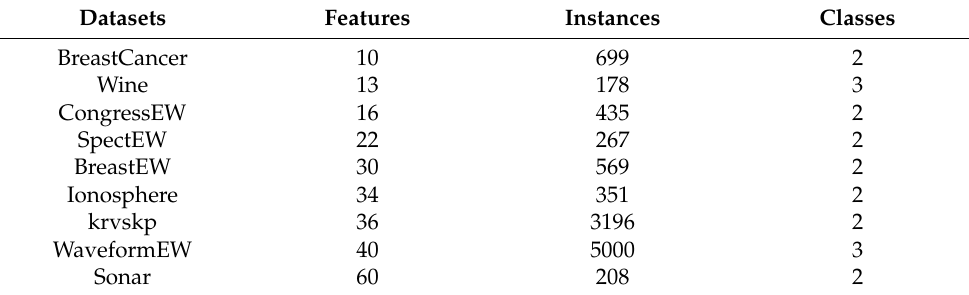
Table 1. Description of UCI benchmark datasets used in this case study.